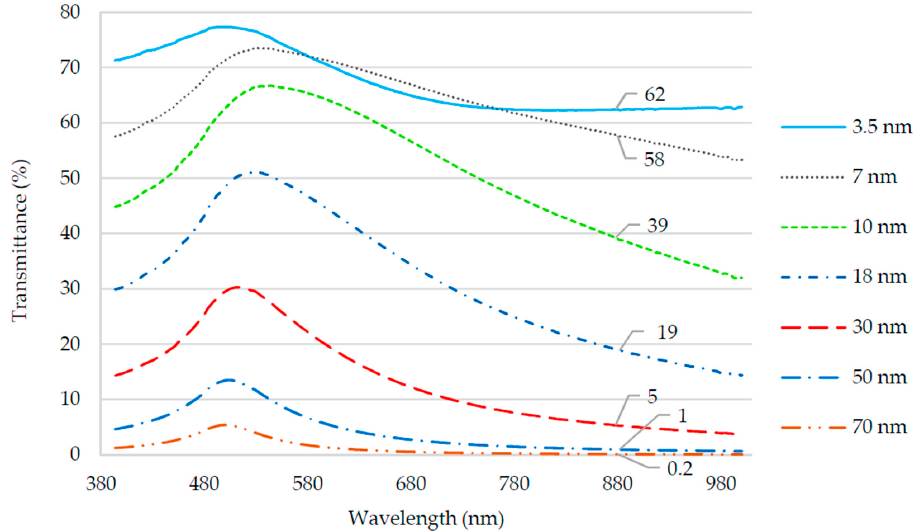
Figure 6. Light spectral transmittance of gold thin films. The transmittance values for 880 nm wavelength (light emitting diode (LED) of Setup 1) for each gold film thickness are shown.